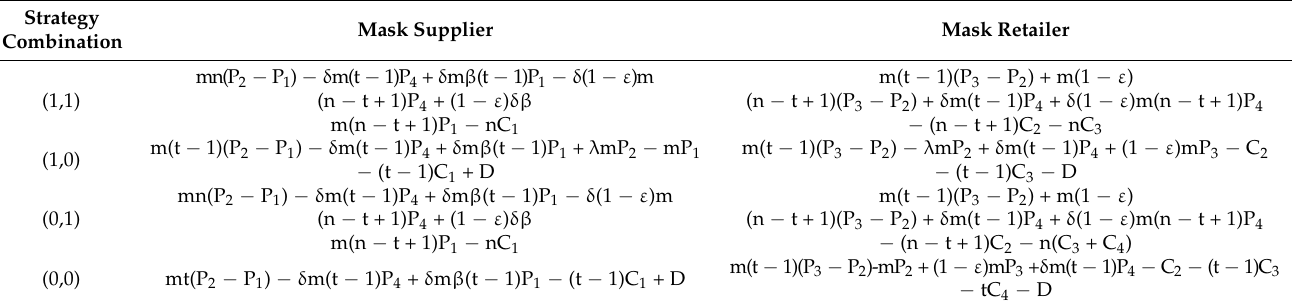
Table 1. Revenue Matrix of Two-party Game